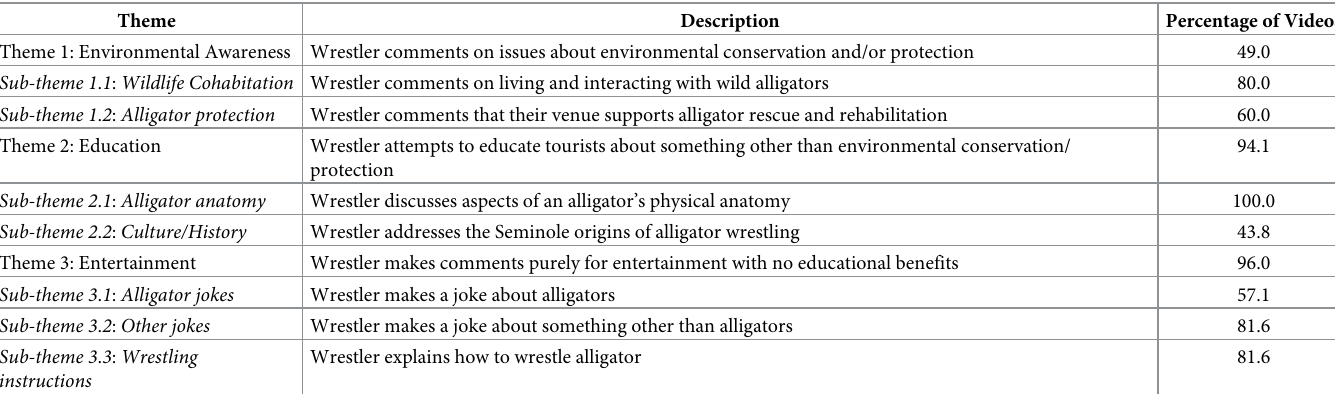
Table 2. Summary of content analysis themes and